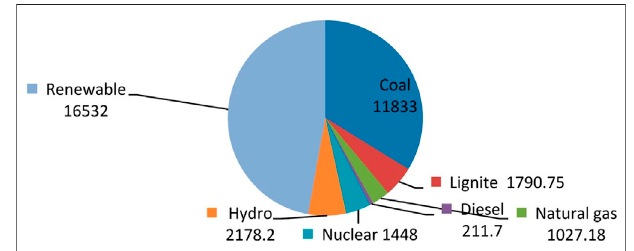
FIGURE 2 | Installed capacity of various resources in Tamil Nadu (including allotted shares in joint and central sectors).